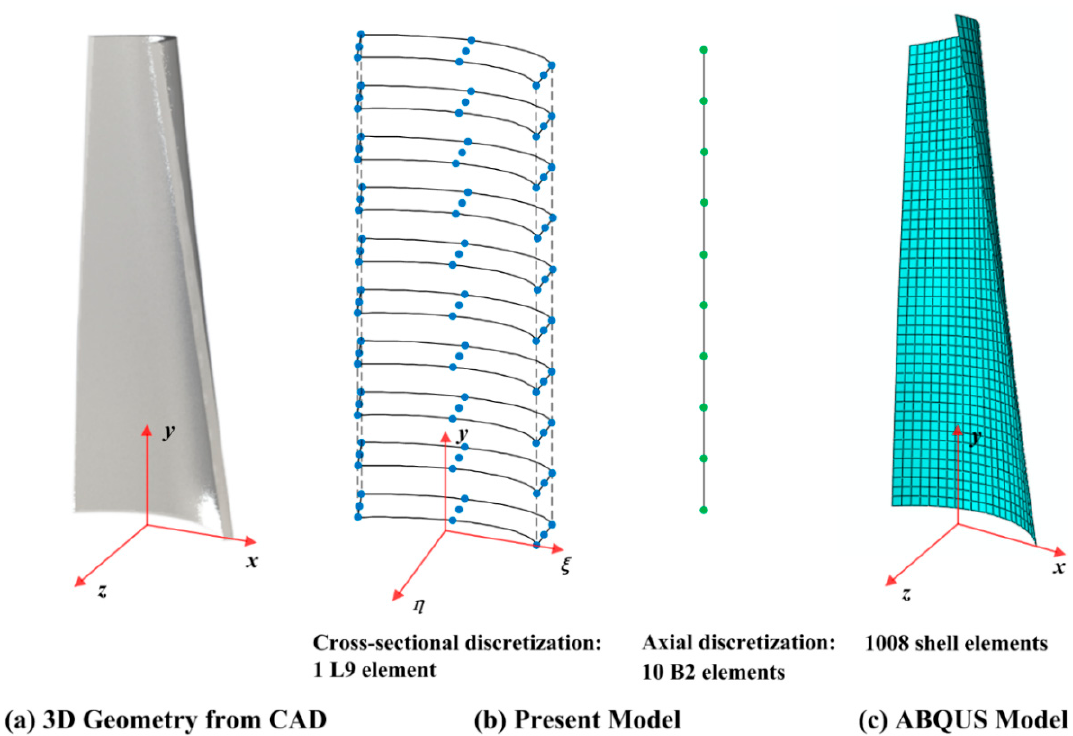
Figure 8. Geometries of a pre-twisted cantilever with arc profile cross section and remarkable dif- ference in discretization between the present model and ABAQUS model: ( a ) 3D geometries from CAD in ( e x , e y , e z ), ( b ) 1 L9 element for cross-sectional discretization and 10 B2 elements for axial discretization based on current formulations in ( e ξ , e y , e η ), and ( c ) converged 1008 shell elements from ABAQUS in ( e x , e y , e z ).